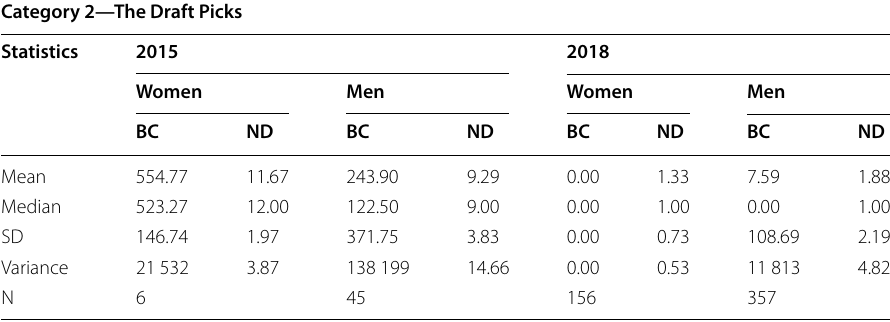
Table 8 Category 2—The Draft Picks: new directors who entered the network between 2015 and